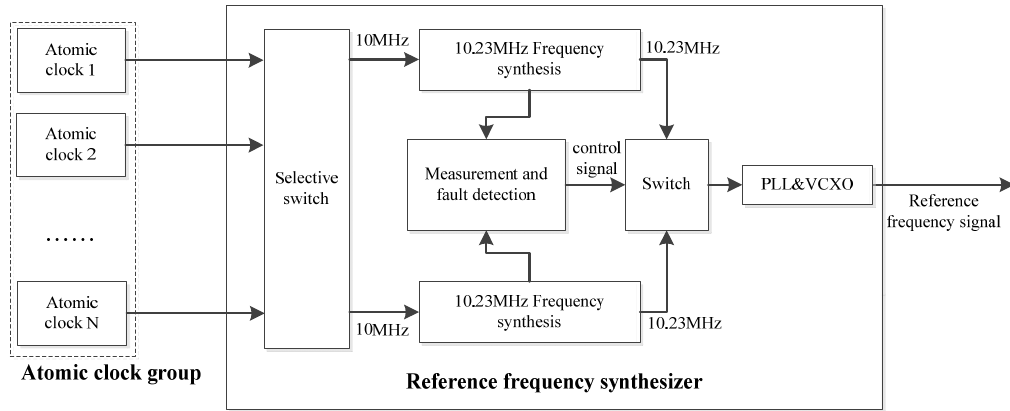
Figure 2. Anomaly monitoring and redundant switching structure of atomic clocks for BDS-3 satellites.